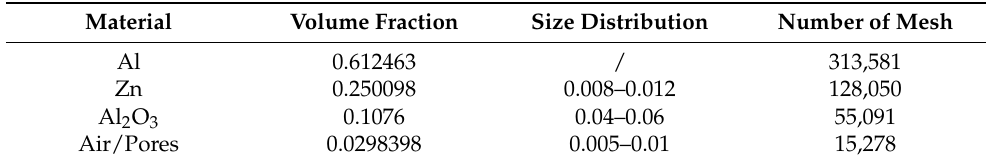
Figure 7. The mesoscopic model: ( a ) geometric model; ( b ) mesh model. Table 5. The setting of each phase in mesoscopic model.